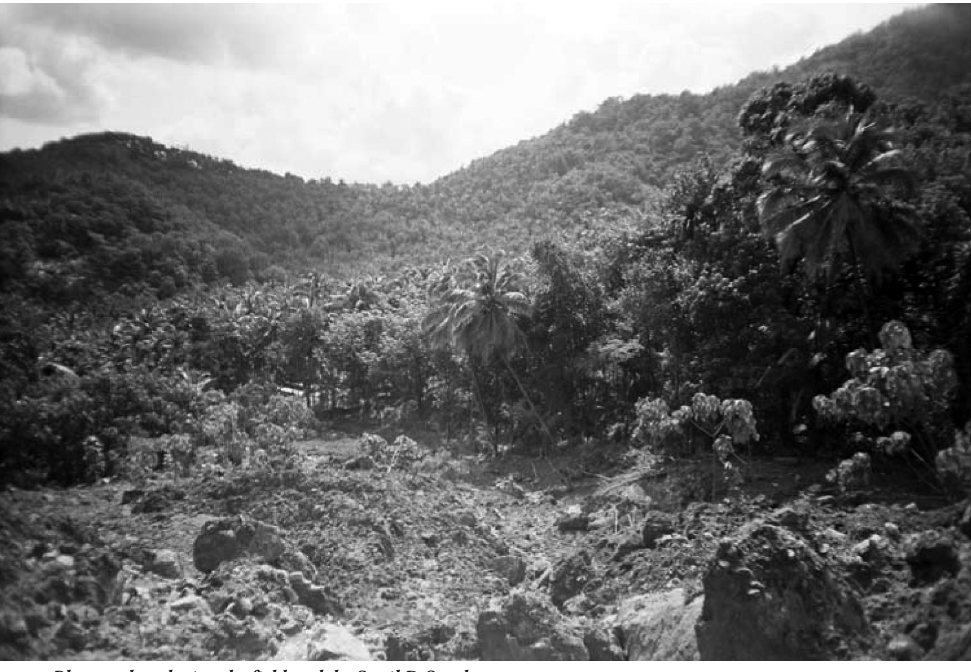
Fig 5: This photograph contrasts how a deeply vegetated hill range has been affected by landslides